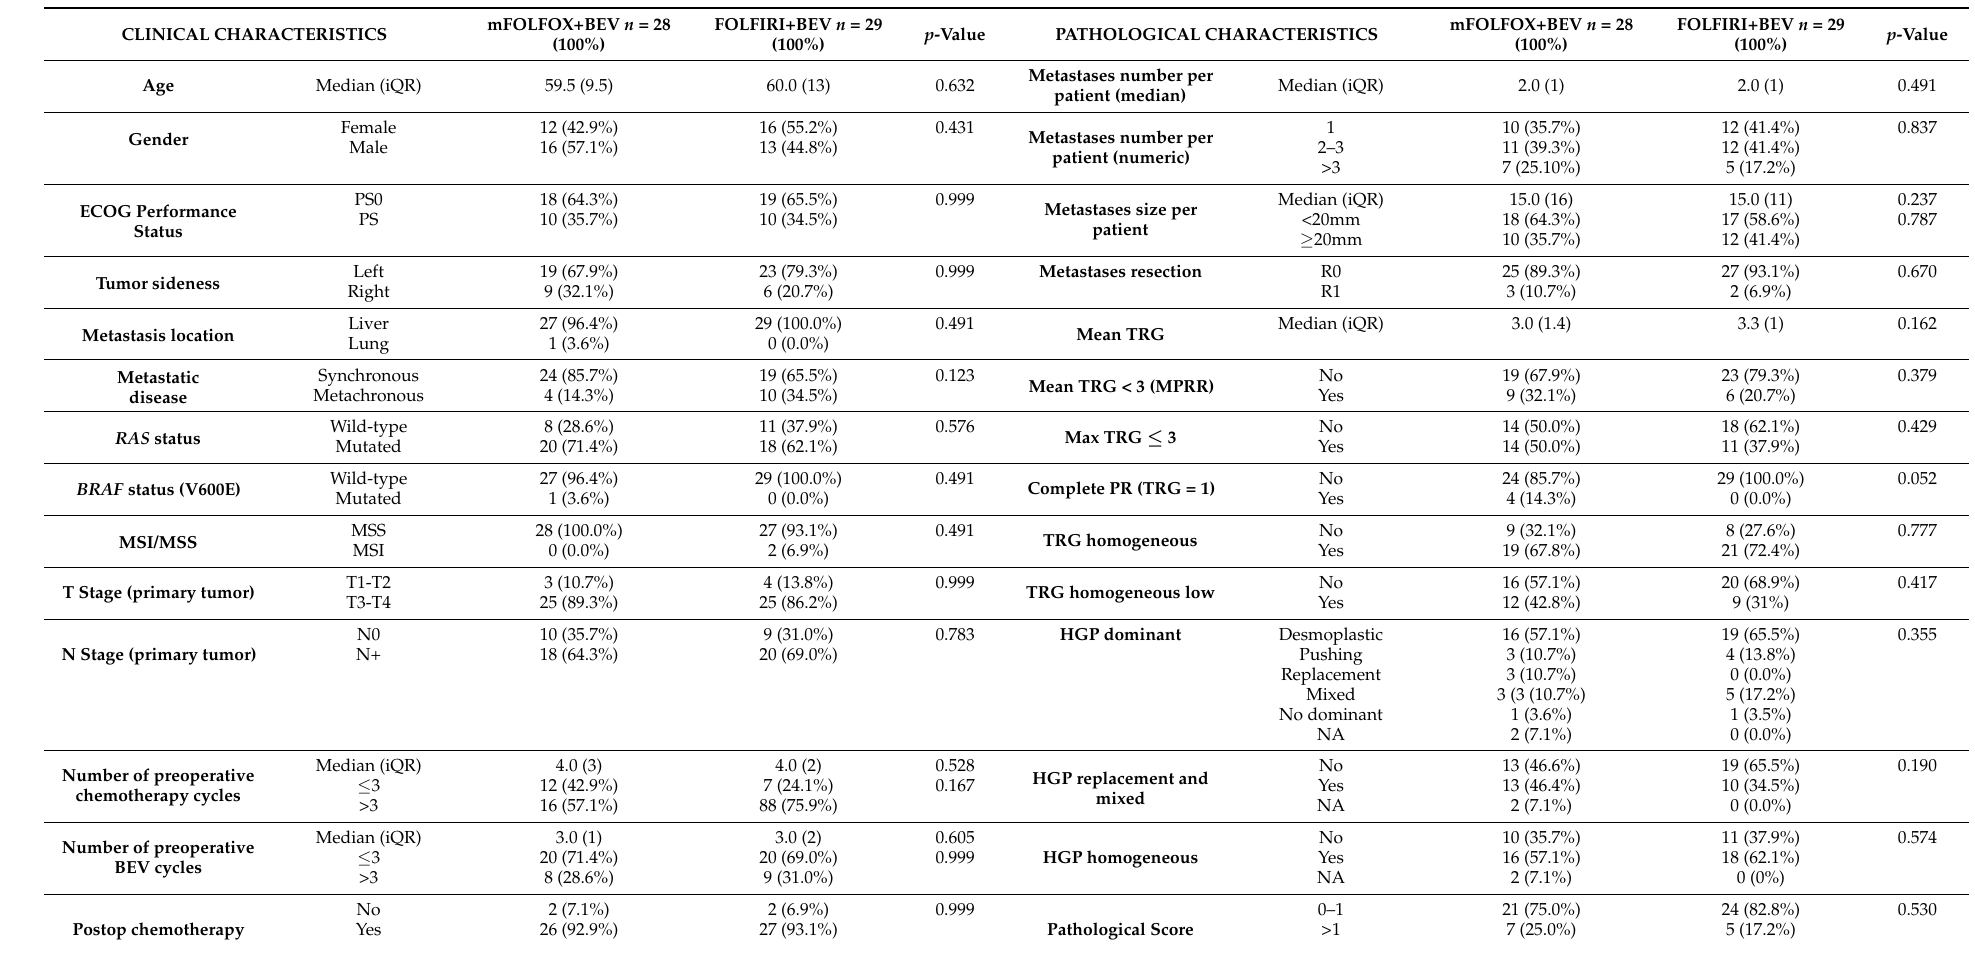
Table 1. Clinico-pathological characteristics of the resected patient